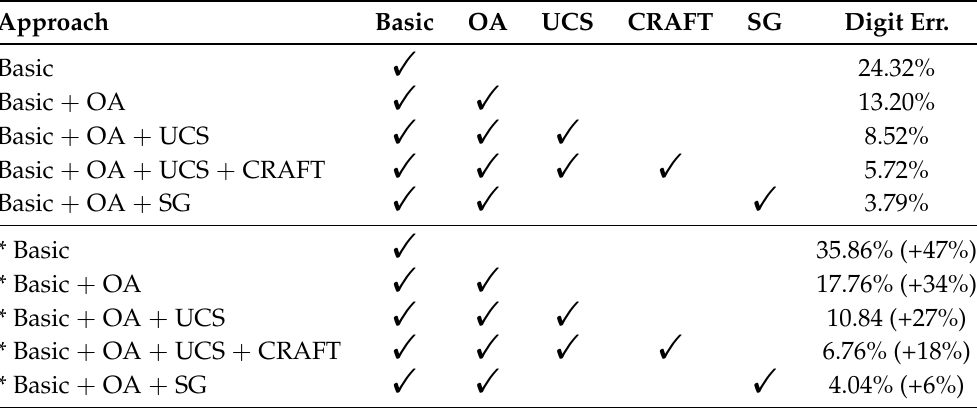
Table 3. Ablation study on the test dataset. “*” represents the test dataset with data augmentation. “Basic” means our baseline network. OA denotes orientation alignment, UCS denotes uniform character segmentation, and SG denotes spatial guidance. The evaluation metrics are the digit error and the error growth